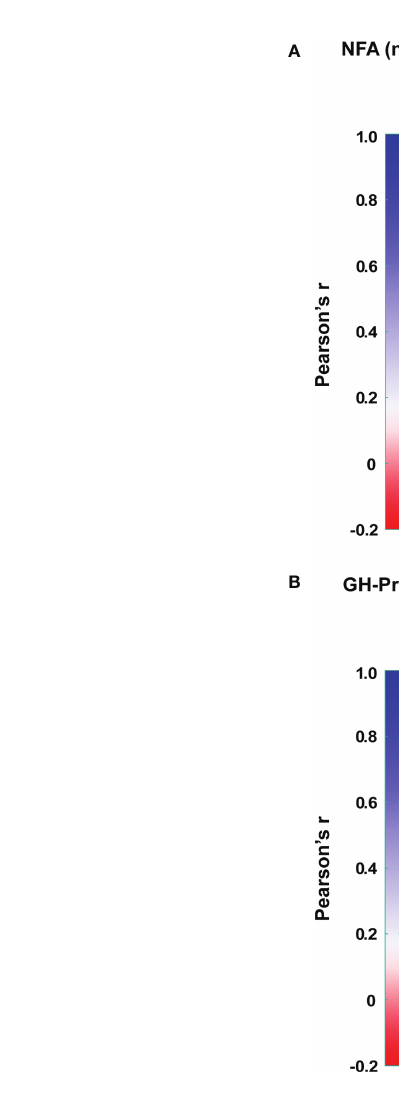
FIGURE 6 | Expression correlation between angiogenic growth factors and endothelial markers. (A) NFA and (B) GH-secreting tumors. Left panel, Pearson ’ s correlation coef fi cients ( r ). Right panel, p